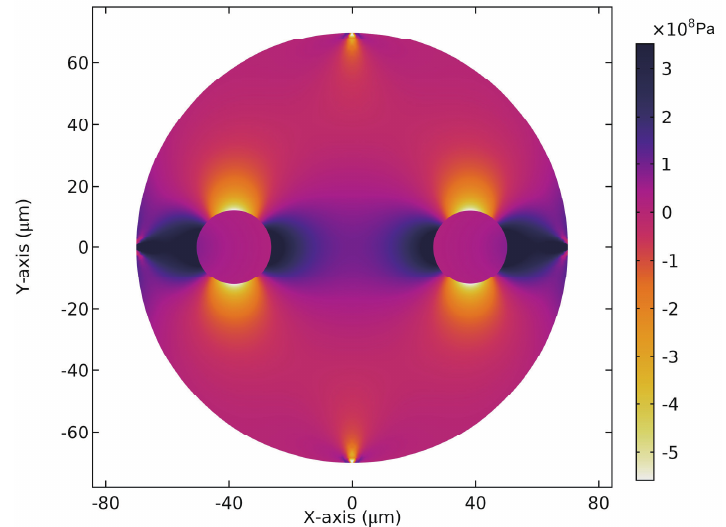
Figure 4. Thermal stress difference σ x − σ y distribution of the SAL PMF cross section, where σ x and σ y are the stress distribution along the slow and fast axes, respectively.